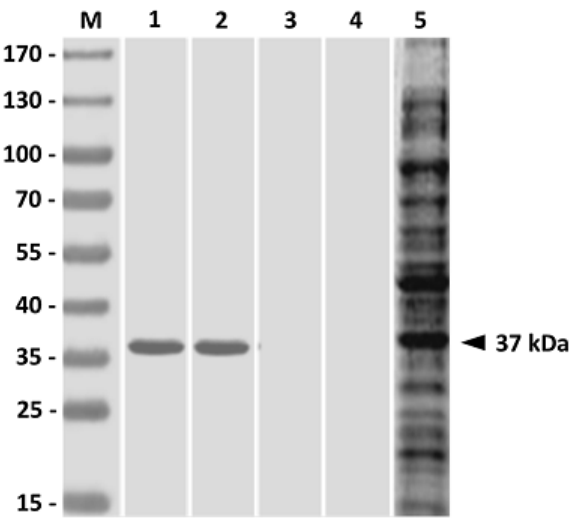
Figure 5. Serum immunoglobulin (Ig) titers against V. harveyi in immunized grouper. Four groups of grouper were intraperitoneally immunized twice (↑) with PLG-PLE/rGAPDH microparticles (■), PLG-rGAPDH microparticles (●), rGAPDH alone (□) or PBS (○). Sera were collected from three fish per group every three weeks, and their anti- V. harveyi serum Ig titers were determined by ELISA. Results were presented as the mean of log * p < 0.05 when comparing the PLG-PLE/rGAPDH group to the PLG-rGAPDH